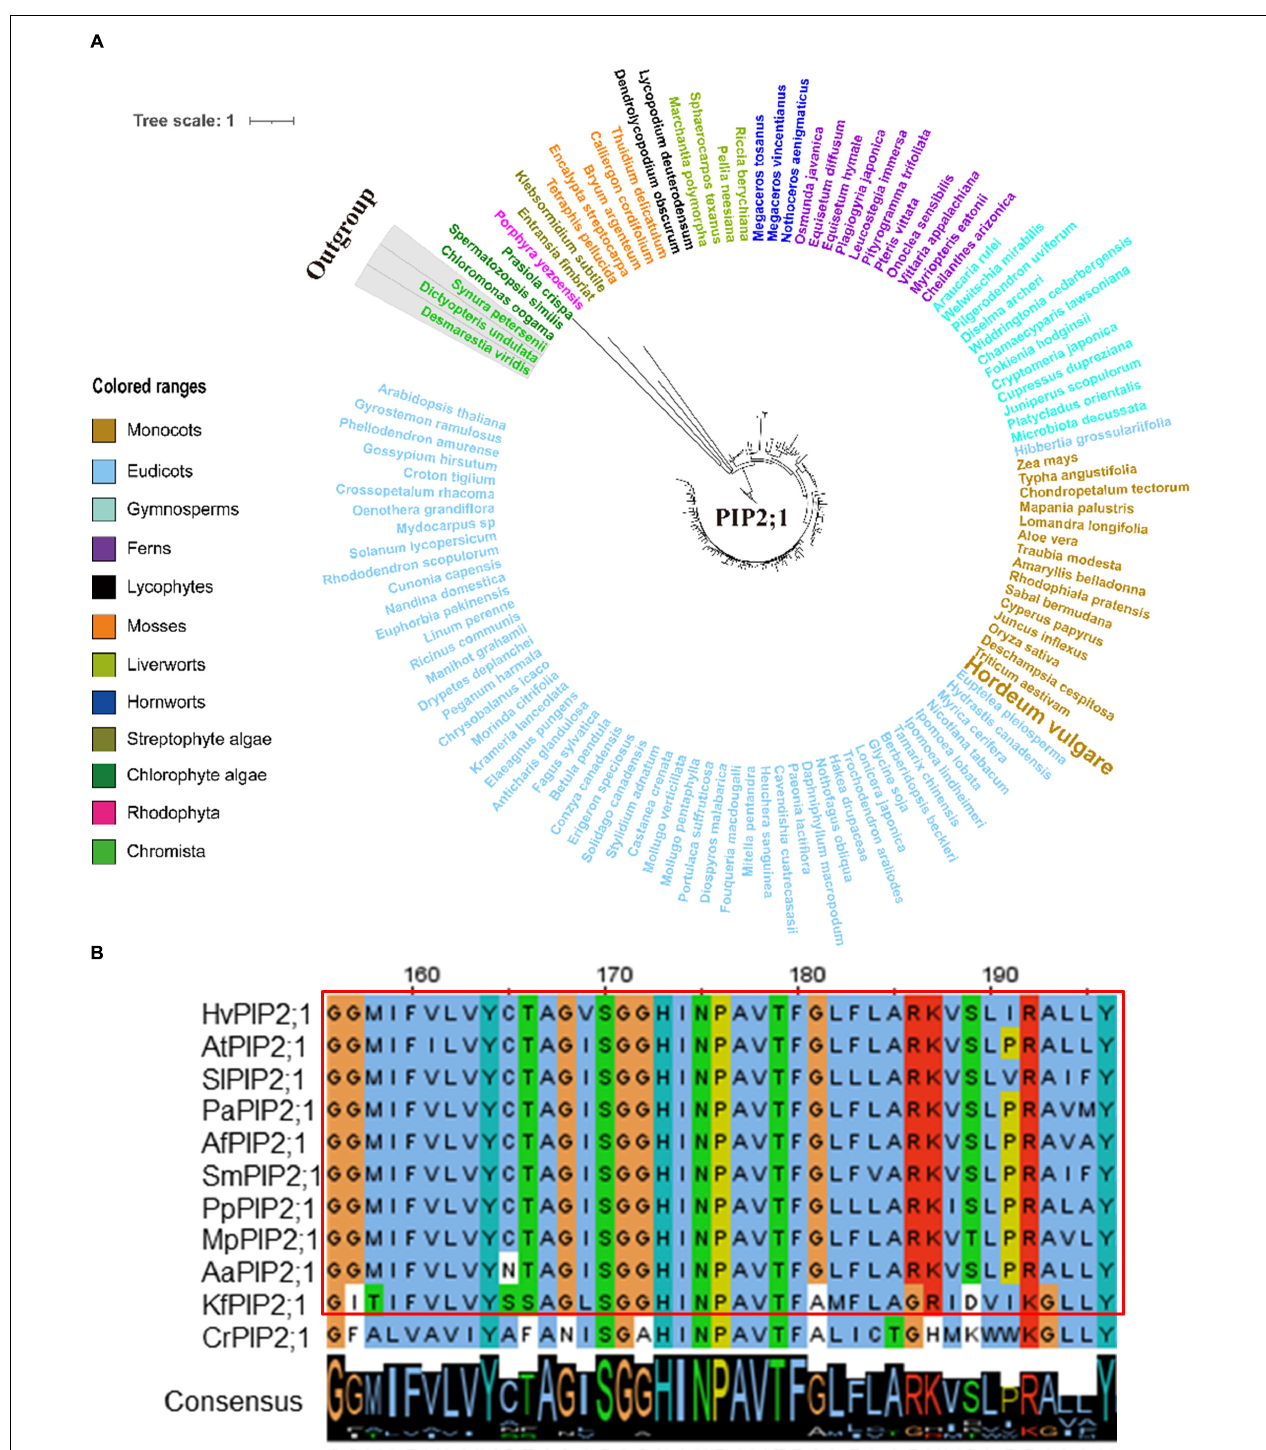
FIGURE 6 | Molecular evolutionary analysis of the aquaporins PIP2;1 in plants and algae. (A) The phylogenetic tree of PIP2;1 proteins in representative species of major lineage of plants and algae (See Supplementary Figure 10A for all OneKP species). The maximum likelihood (ML) method was used to construct the tree. Clades are indicated by different colors. (B) Conserved motif alignment of PIP2;1 in eleven representative plants and algal species. Hv, Hordeum vulgare; At, Arabidopsis thaliana; Sl, Solanum lycopersicum; Pa, Piceaabies; Af, Azolla filiculoides; Sm, Selaginella moellendorffii; Pp, physcomitrella patens; Mp, Marchantia polymorpha; Aa, Anthoceros angustus; Kf, Klebsormidium flaccidum; Cr, Chlamydomonas reinhardtii .